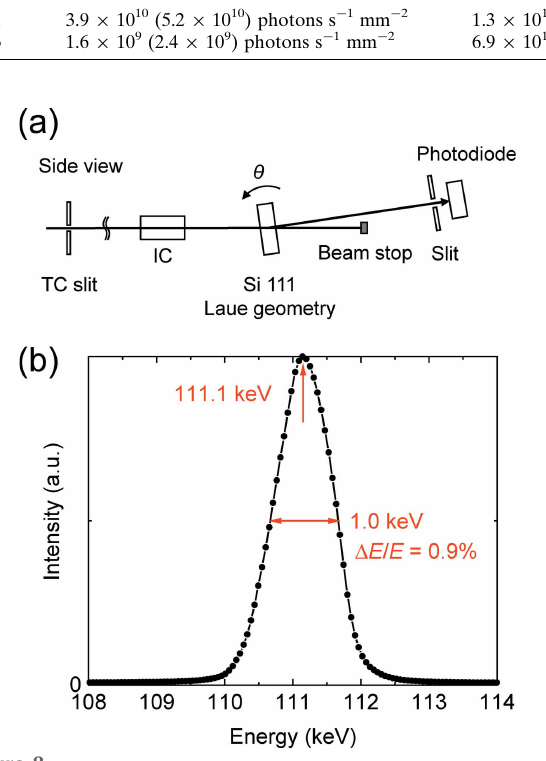
Figure 8 ( a ) Schematic of the spectrum measurement for the 110 keV DMM and ( b ) the measured spectrum.